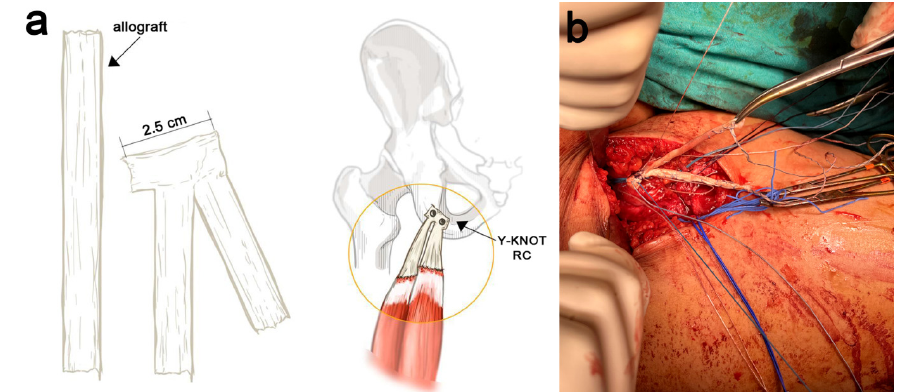
Figure 4. Semitendinosus tendon allograft preparation. ( a ) Description of allograft preparation and placement. ( b ) Intraoperative image showing the two branches of the allograft (inverted V-shaped).